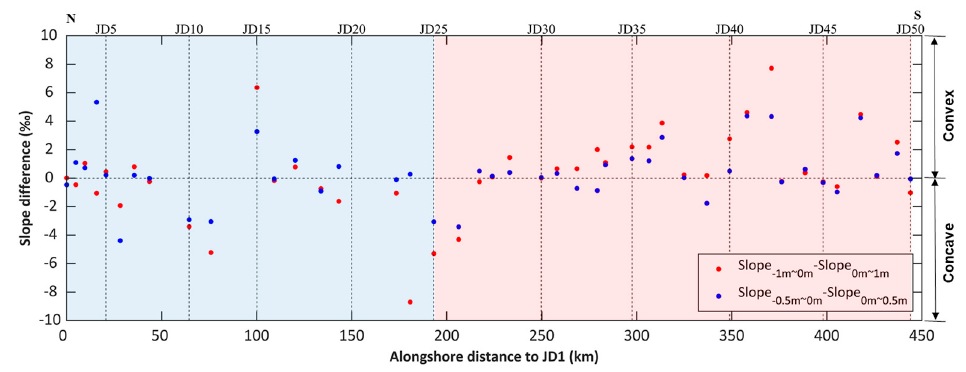
Figure 15. Upper and lower intertidal beach slope difference of the 50 profiles calculated with different boundaries.